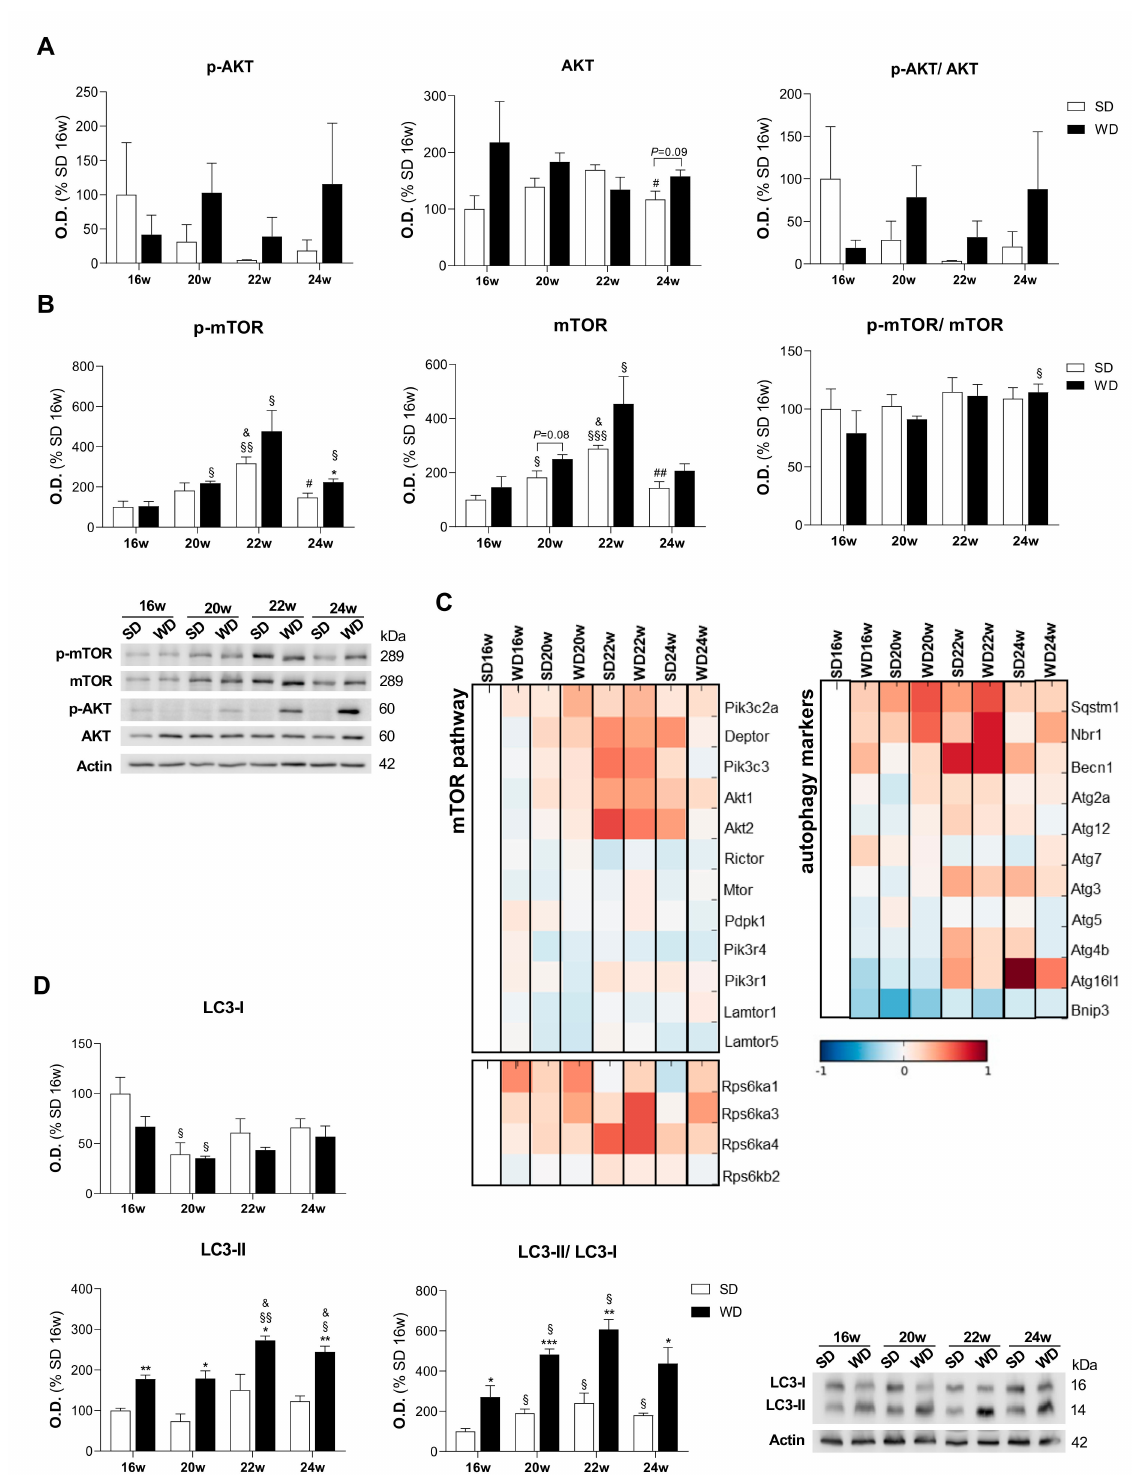
Figure 7. Western diet (WD) is associated with an accumulation of LC3-II and p62 levels in the hepatic tissue. ( A ) Protein level of phosphorylated AKT, total AKT, and p-AKT/AKT ratio. ( B ) Protein level of phosphorylated mTOR, total mTOR,